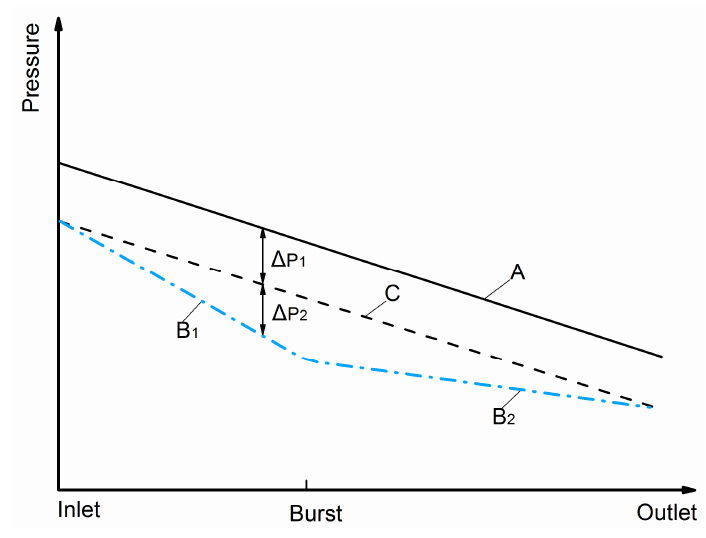
Figure 7. Pressure variation along the pipe.